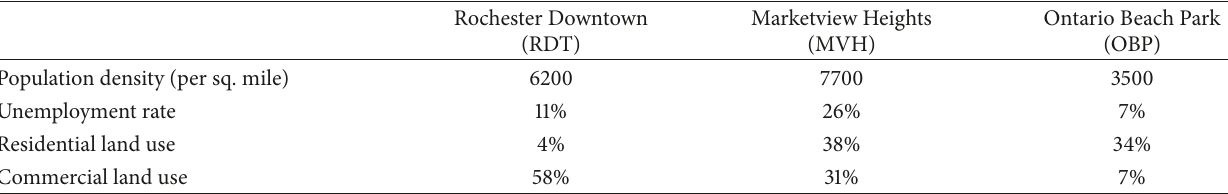
Table 1: Land use around public charging stations [25, 26] (for 1/4 mile radius). Rochester